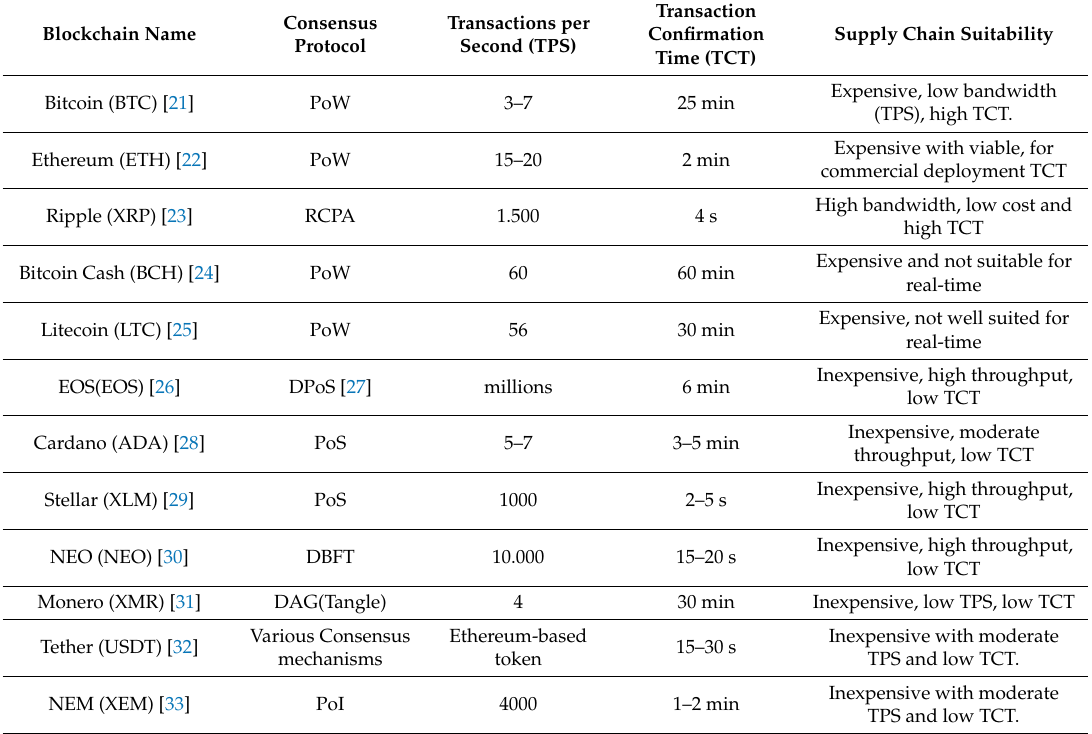
Table 3. Comparison of blockchain performance characteristics and assessment of suitability for supply chain management (at the time of writing this